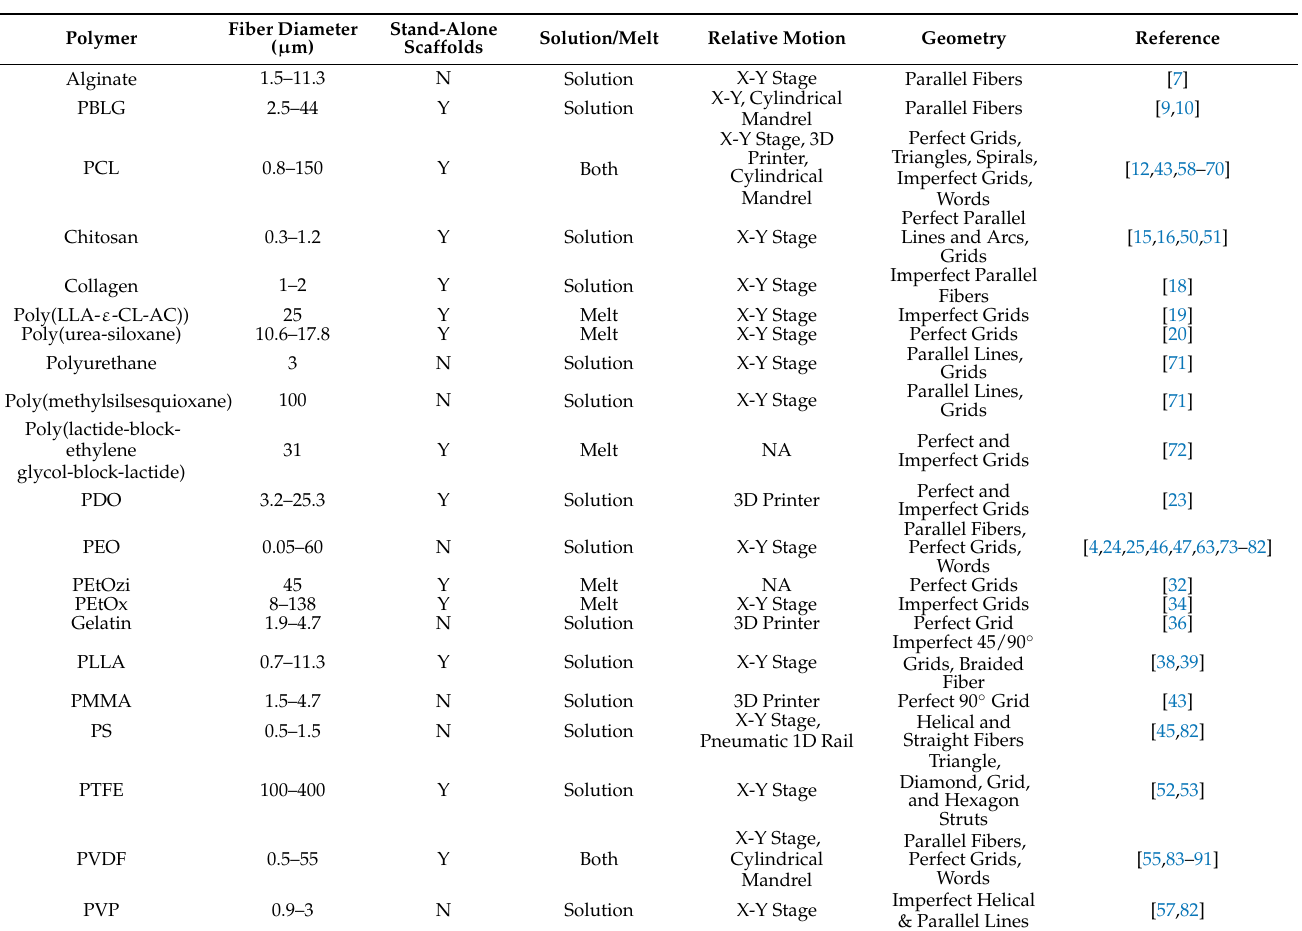
Table 1. Collated fiber diameter ranges, fiber write apparatus, and scaffold creation of NFES/MEW processed biomedical